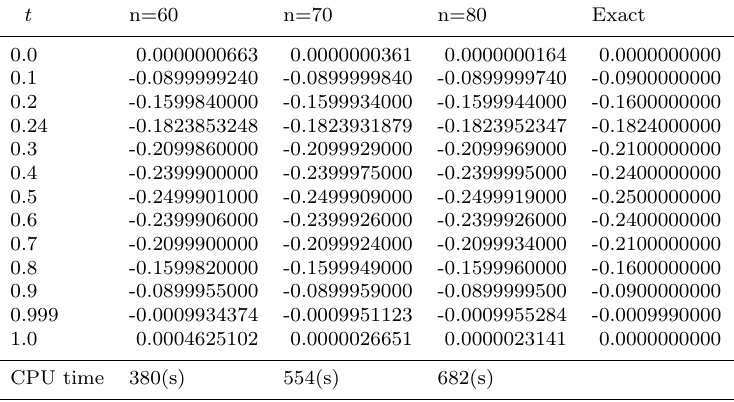
Table 1. Estimated and exact value of x ( t ) for n = 60 , 70 , 80 of Example 1.